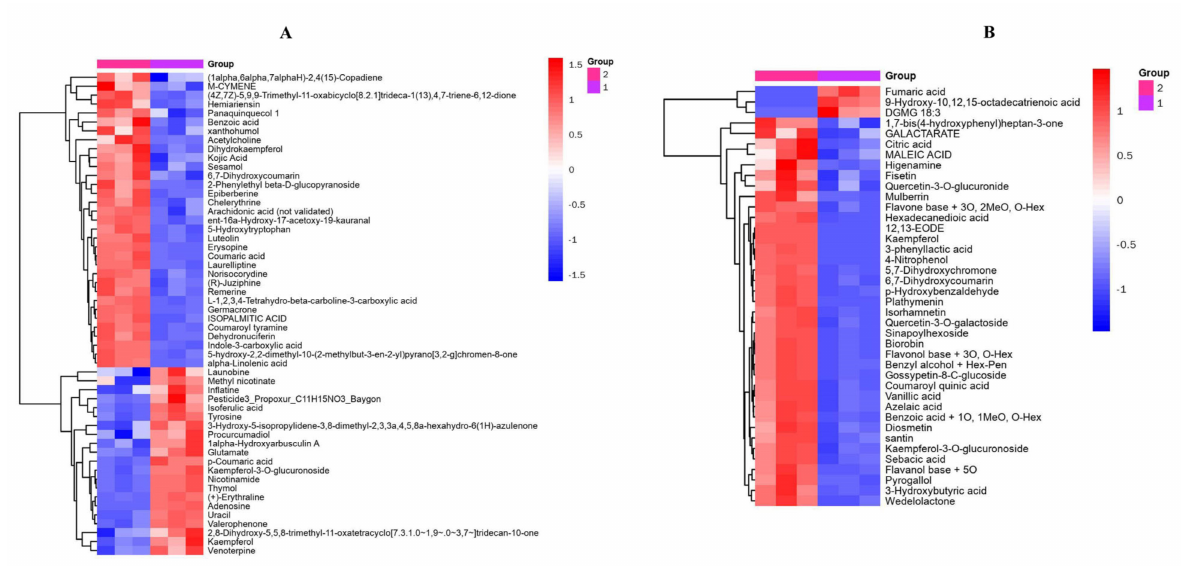
Figure 4. Heatmap of hierarchical clustering analysis for the FLL group (2, blue square) vs. the LL group (1, red circle). ( A ) Positive-ion mode; ( B ) Negative-ion